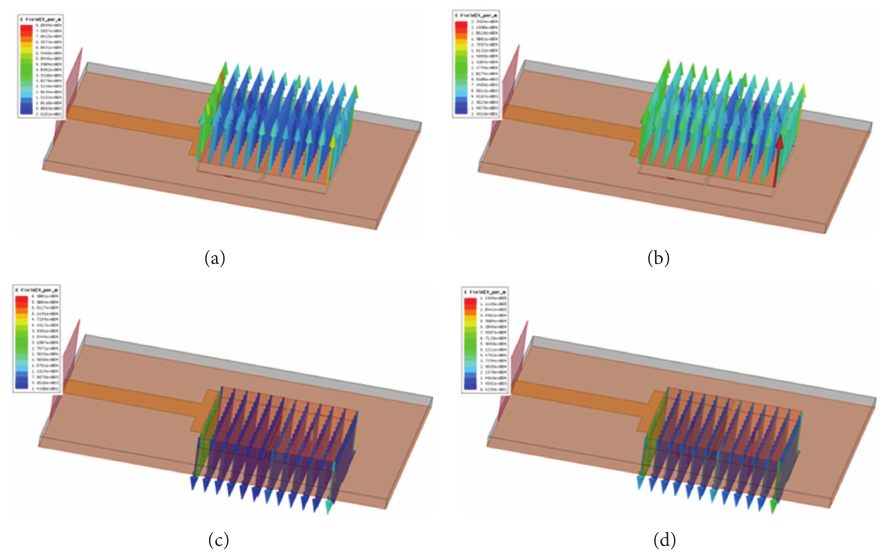
Figure 7: Electric field distributions with zero propagation constant at different phases: (a) 80 ∘ , (b) 110 ∘ , (c) 140 ∘ , and (d) 170 ∘ .